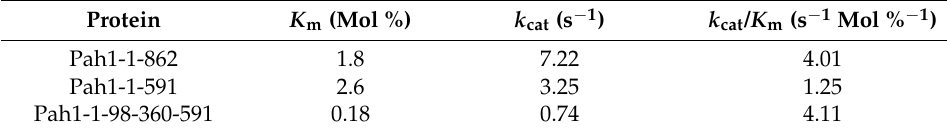
Table 2. Kinetic parameters of full-length and truncations of